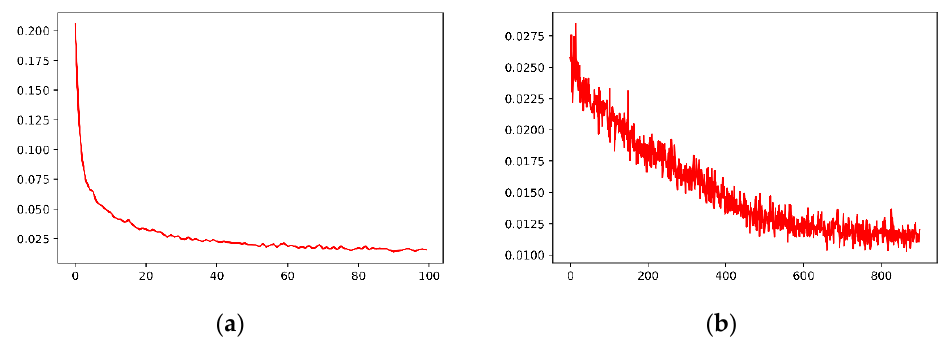
Figure 10. Loss curves of deep learning training. ( a ) Densenet121 loss curve. ( b ) Vision Transformer loss curve.